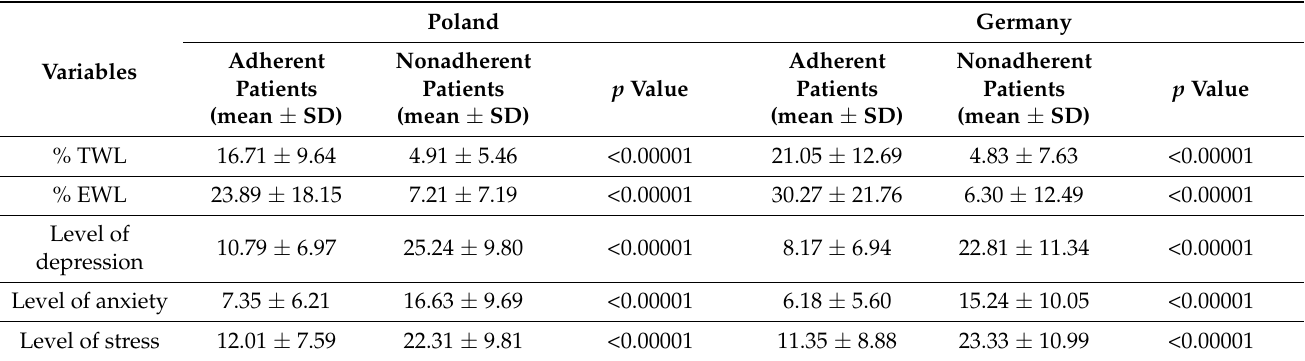
Table 3. Influence of adherence to medical recommendations on weight loss and mental health of morbidly obese patients in Poland ( n = 354) and Germany ( n =